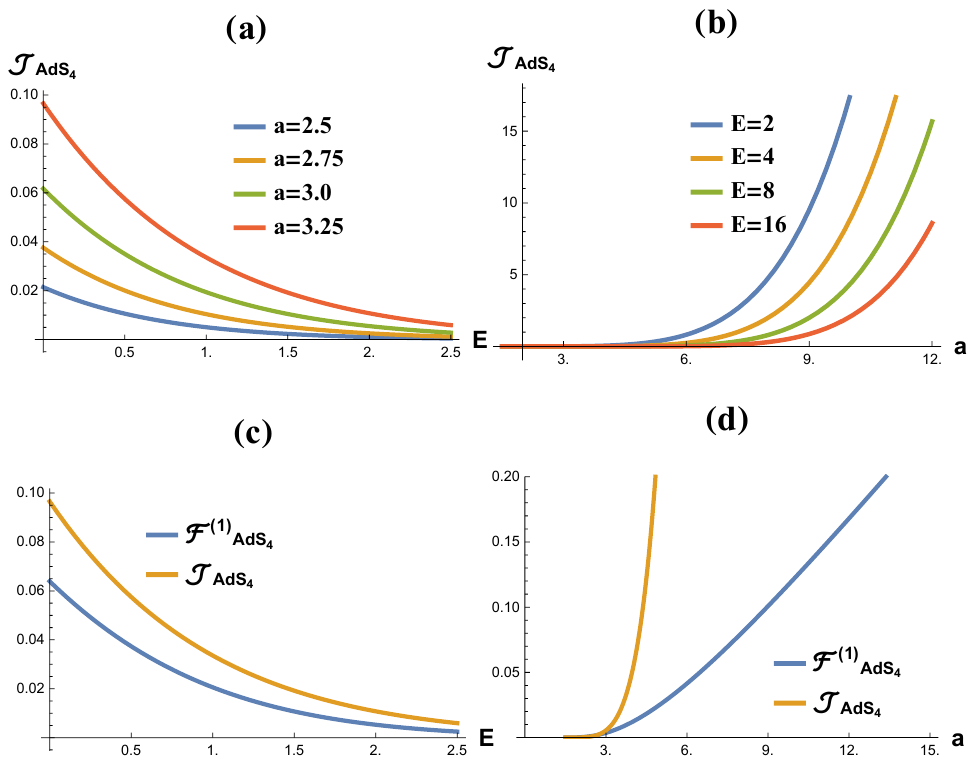
Figure 5 . Plot (a) denotes fermionic detector response function J AdS as a function of energy 4 with different acceleration and (b) as a function of acceleration with different energy. Finally, we compare the scalar F (1) and fermionic J AdS response functions for specific value of a = 3 . 25 AdS 4 4 (plot (c)) and E = 2 (plot (d)). We used k = 1 as well in figure